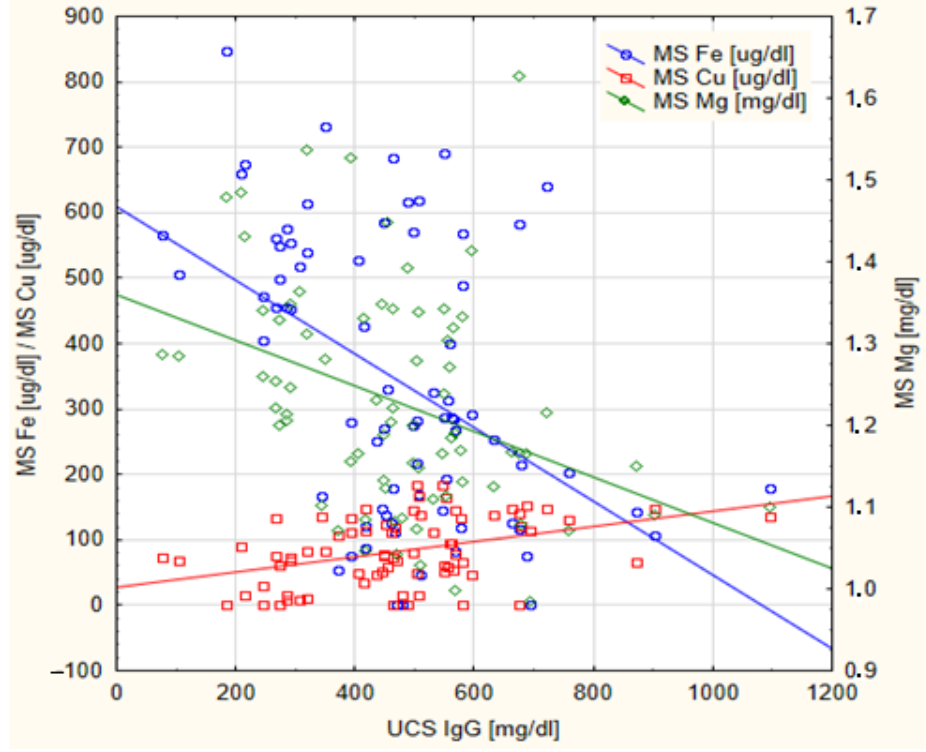
Figure 1. The scatterplot of the concentrations of IgG antibodies in the cord blood serum (UCS IgG) of newborns in relation to the concentration of iron (MS Fe), copper (MS Cu) and magnesium (MS Mg) in maternal serum.